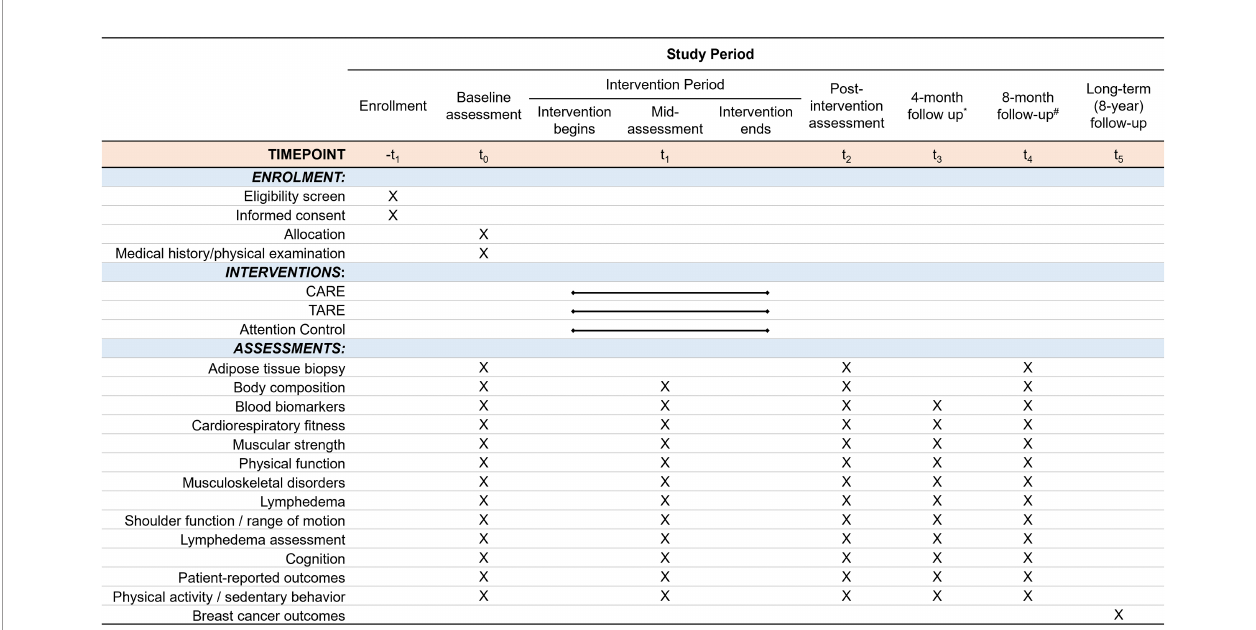
FIGURE 3 | Study timeline of the AIM Trial. CARE, Circuit Aerobic and Resistance Exercise; TARE, Traditional Aerobic and Resistance Exercise; AC, Attention Control. All three groups are assessed otherwise noted. Follow-up timepoints are de fi ned as the period from the post-intervention assessments. *Participants in the